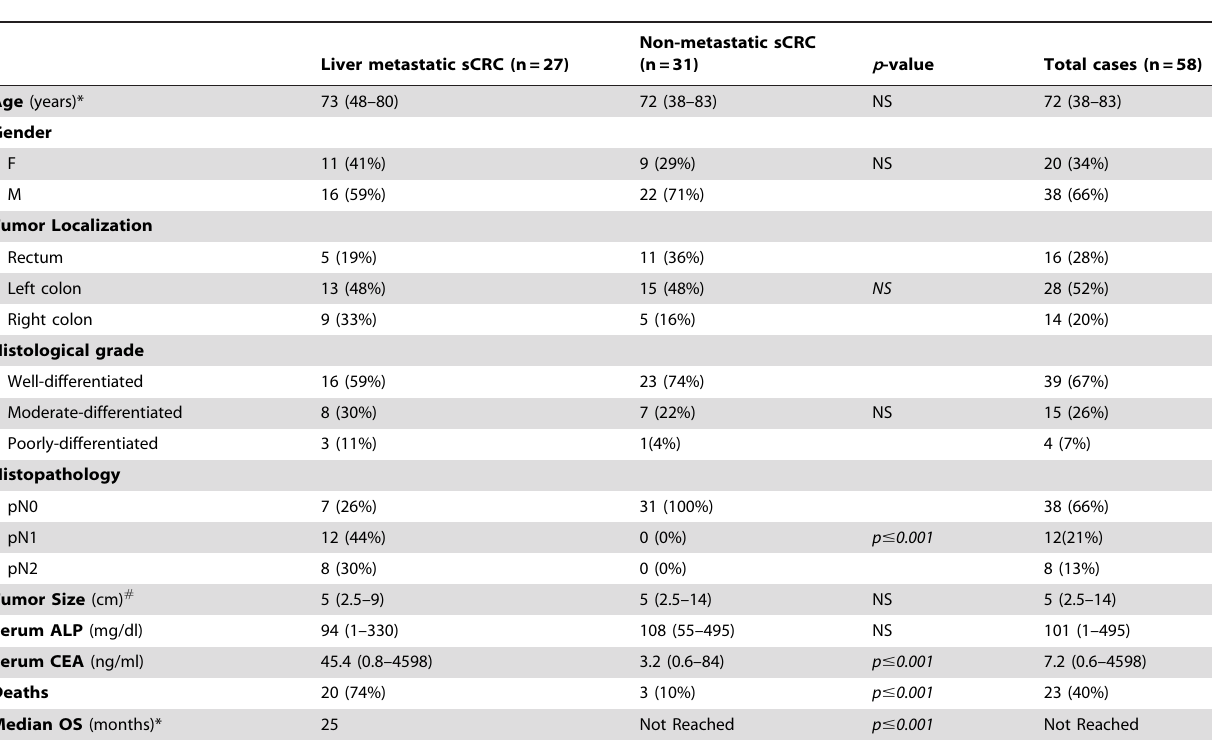
Table 1. Clinical and biological characteristics of liver metastatic (n=27) versus non-metastatic (n =31) sporadic colorectal carcinoma (sCRC)